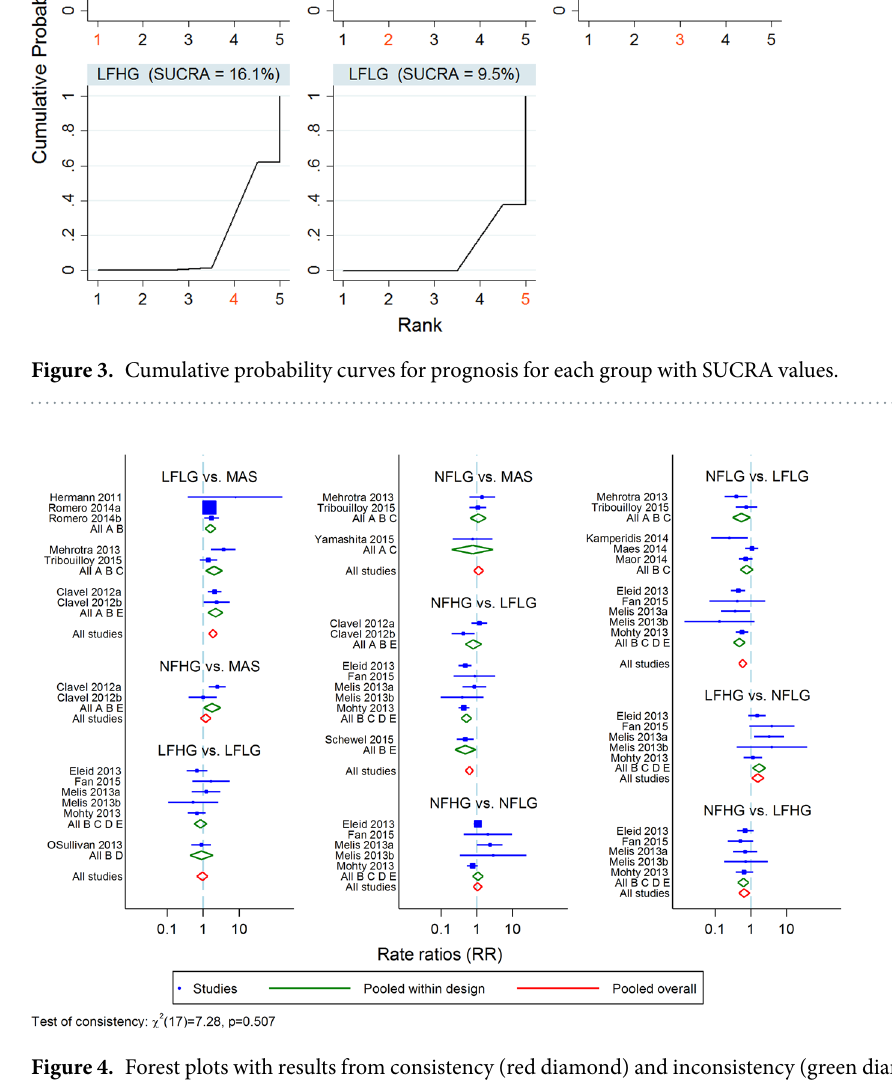
Figure 4. Forest plots with results from consistency (red diamond) and inconsistency (green diamond)